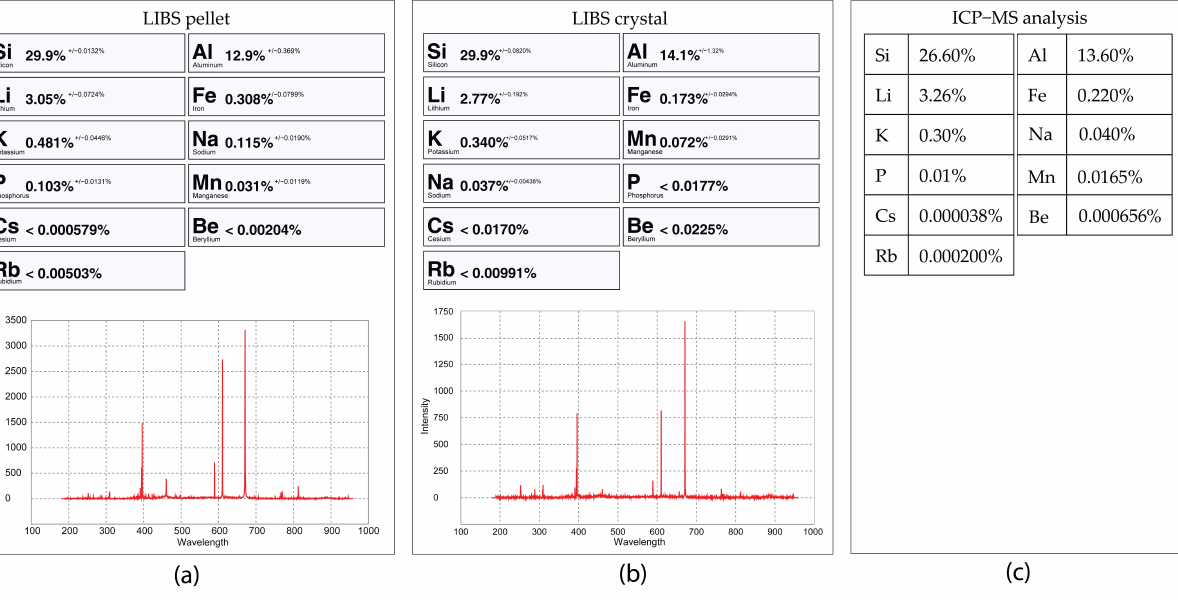
Figure 27. LIBS analysis of the spodumene sample 32-C1 in pellet ( a ) compared with the crystal sample ( b ) and the ICP-MS analysis ( c ). These LIBS analyses were performed with the Spd_Barroso calibration.